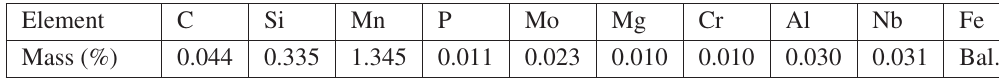
Table 1. Chemical compositions of the low-carbon microalloyed steels (mass %). Annealing Temperature